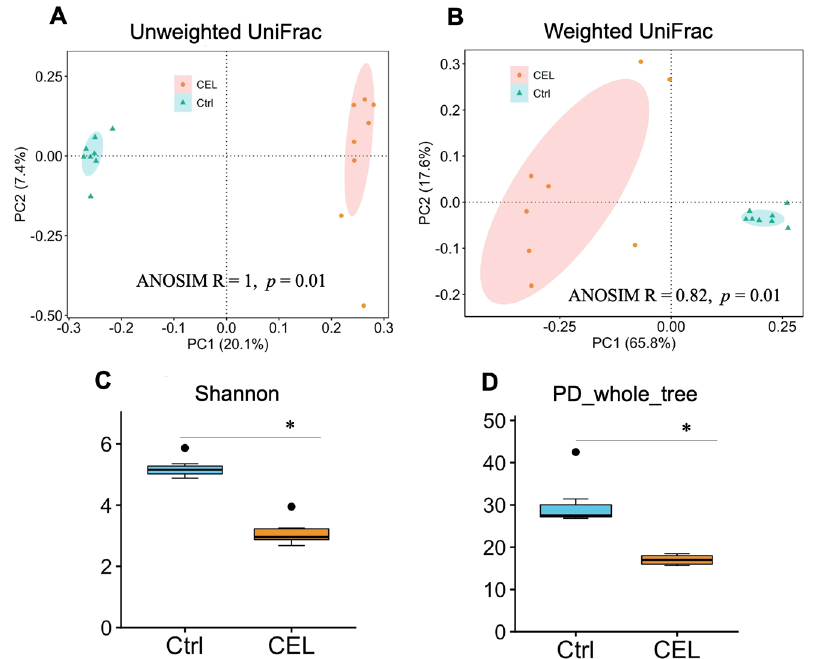
Figure 1. Effects of supplemental CEL on cecal microbiome profiles and alpha diversity. PCoA of unweighted ( A ) and weighted UniFrac ( B ) and PERMANOVA analyses were performed to compare the gut microbiome profiles of the experimental groups. The diversity of the gut microbiota within samples was measured by ( C ) Shannon index and ( D ) PD whole tree. Data are presented as a boxplot with median and min–max whiskers. The dots (•) in the boxplots are outliers. * Significantly different at p < 0.05 (Welch’s t ‐ test).